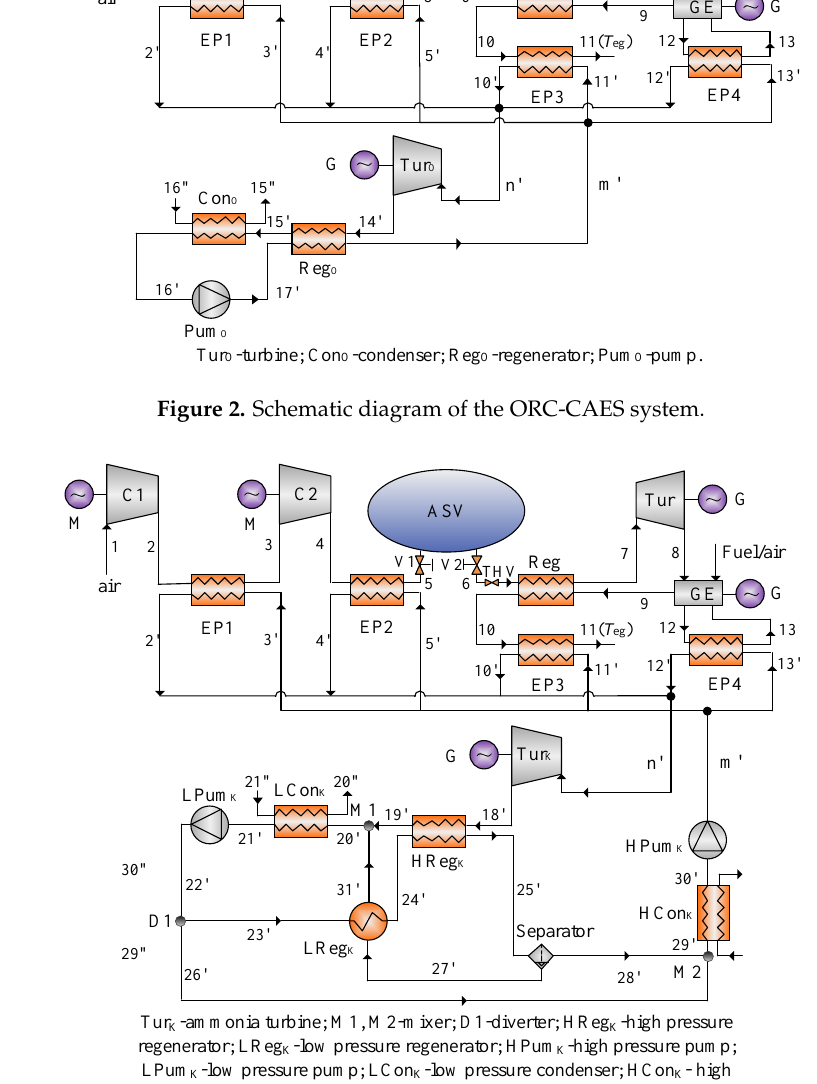
Figure 3. Schematic diagram of the Kalina cycle (KC)-CAES